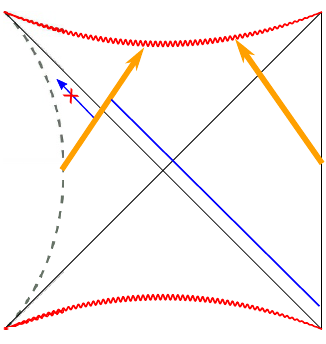
Figure 9 . Experiment